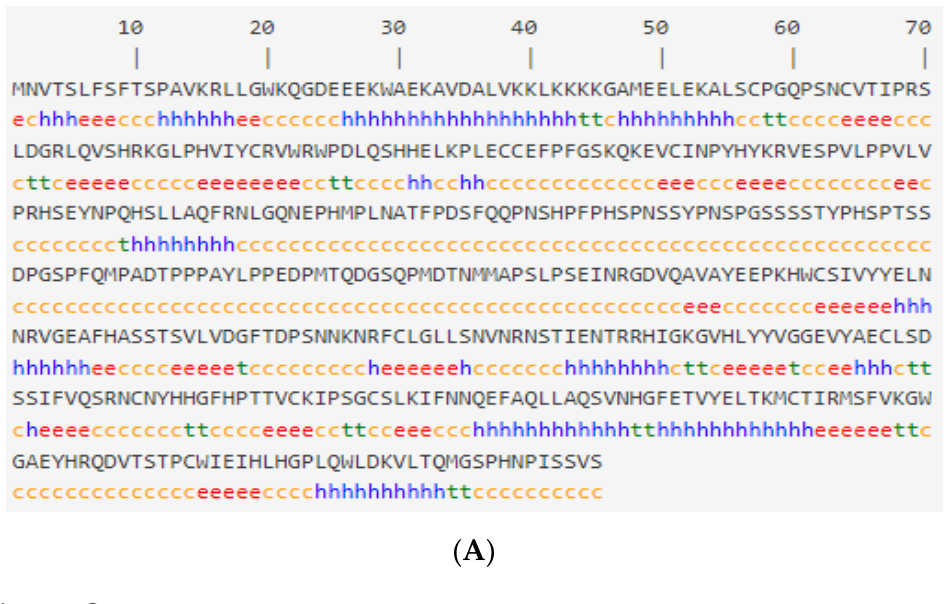
Figure 2. Phylogenetic tree of SMAD1 ( A ), SMAD2 ( B ) and SMAD3 ( C ) of Tibetan sheep with 11 other species. The red highlighted text is the species studied in this article.